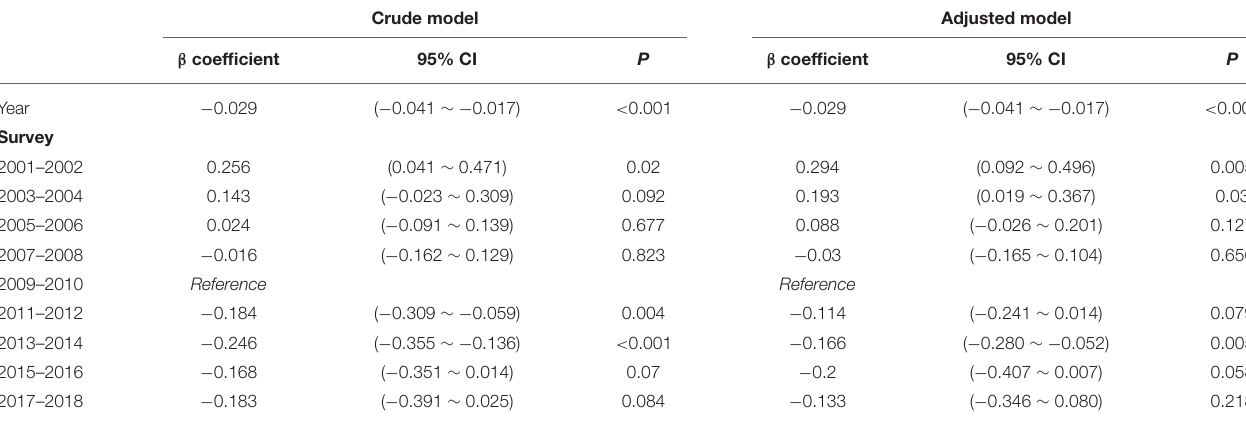
TABLE 3 | The weighted linear regression for the time-related change in blood lead level in pregnant